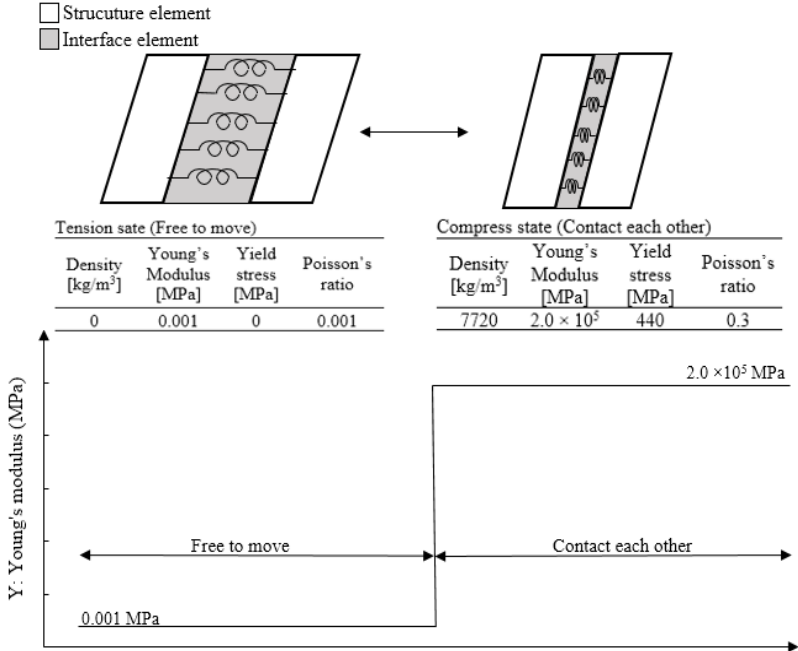
Figure 3. Concept of interface element.